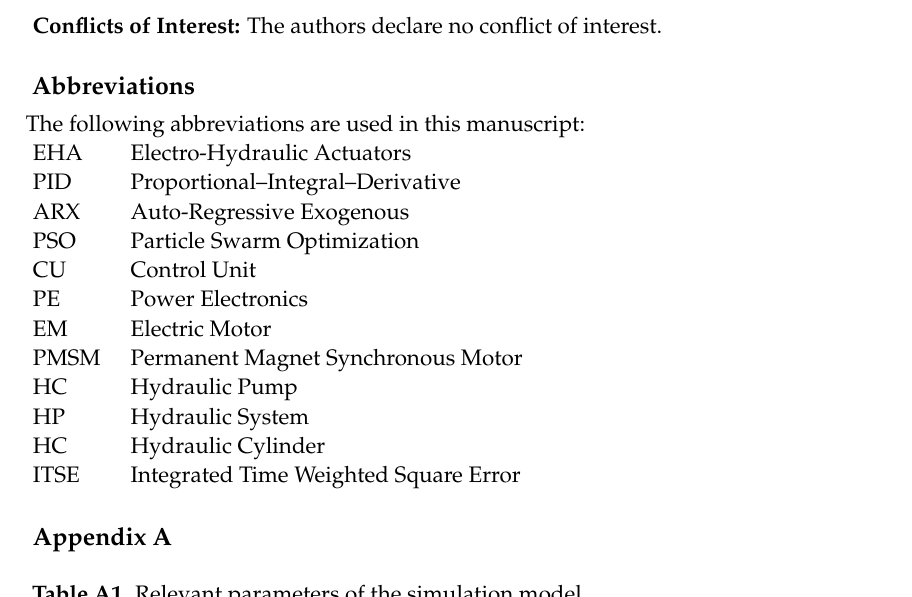
Table A1. Relevant parameters of the simulation